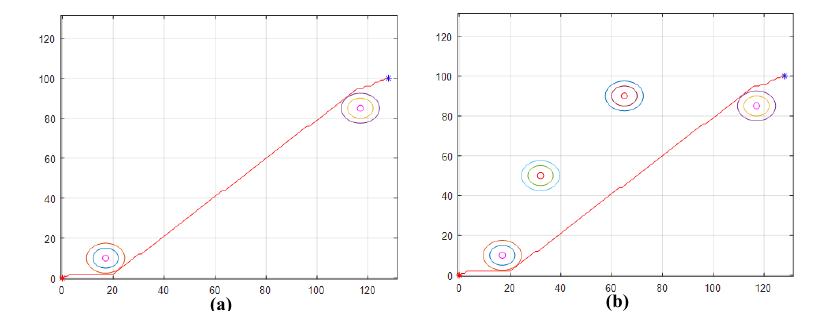
Fig. 7. Scenario 1 initial path and modified algorithm path.